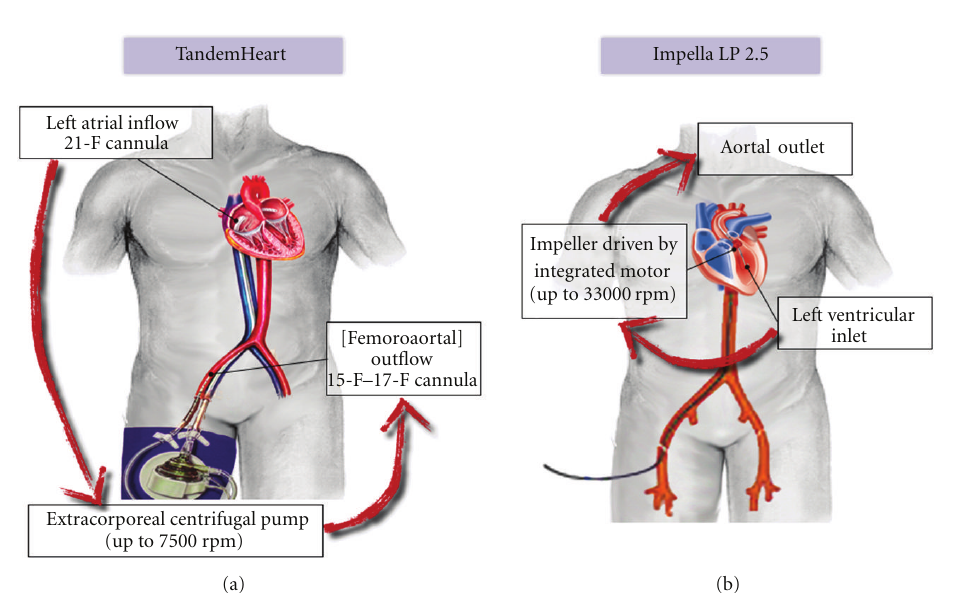
Figure 1: Schematic representation of two commercially available percutaneous ventricular assist devices (VAD). (a) The TandemHeart pVAD consists of a 21F left atrial inflow cannula, an extracorporeal centrifugal pump rotating at up to 7500 rpm, a femoral outflow cannula (15F–17 F) that extends into the iliac artery, and a microprocessor-based pump controller, which can provide blood flow up to 4L/min. The tip of the atrial drainage cannula is positioned under fluoroscopic guidance into the left atrium following transseptal puncture. (b) The Impella LP 2.5 is a catheter-mounted device. The microaxial pump consists of an impeller driven by an integrated microelectric motor on the distal end of a flexible catheter. At a maximum speed of 33,000 rpm, the pump provides a maximum hydraulic capacity of 2.5 L/min. The Impella Recover LP 2.5 is retrogradely placed across the aortic valve into the left ventricle where it aspirates blood via a caged blood flow inlet which is then ejected into the ascending